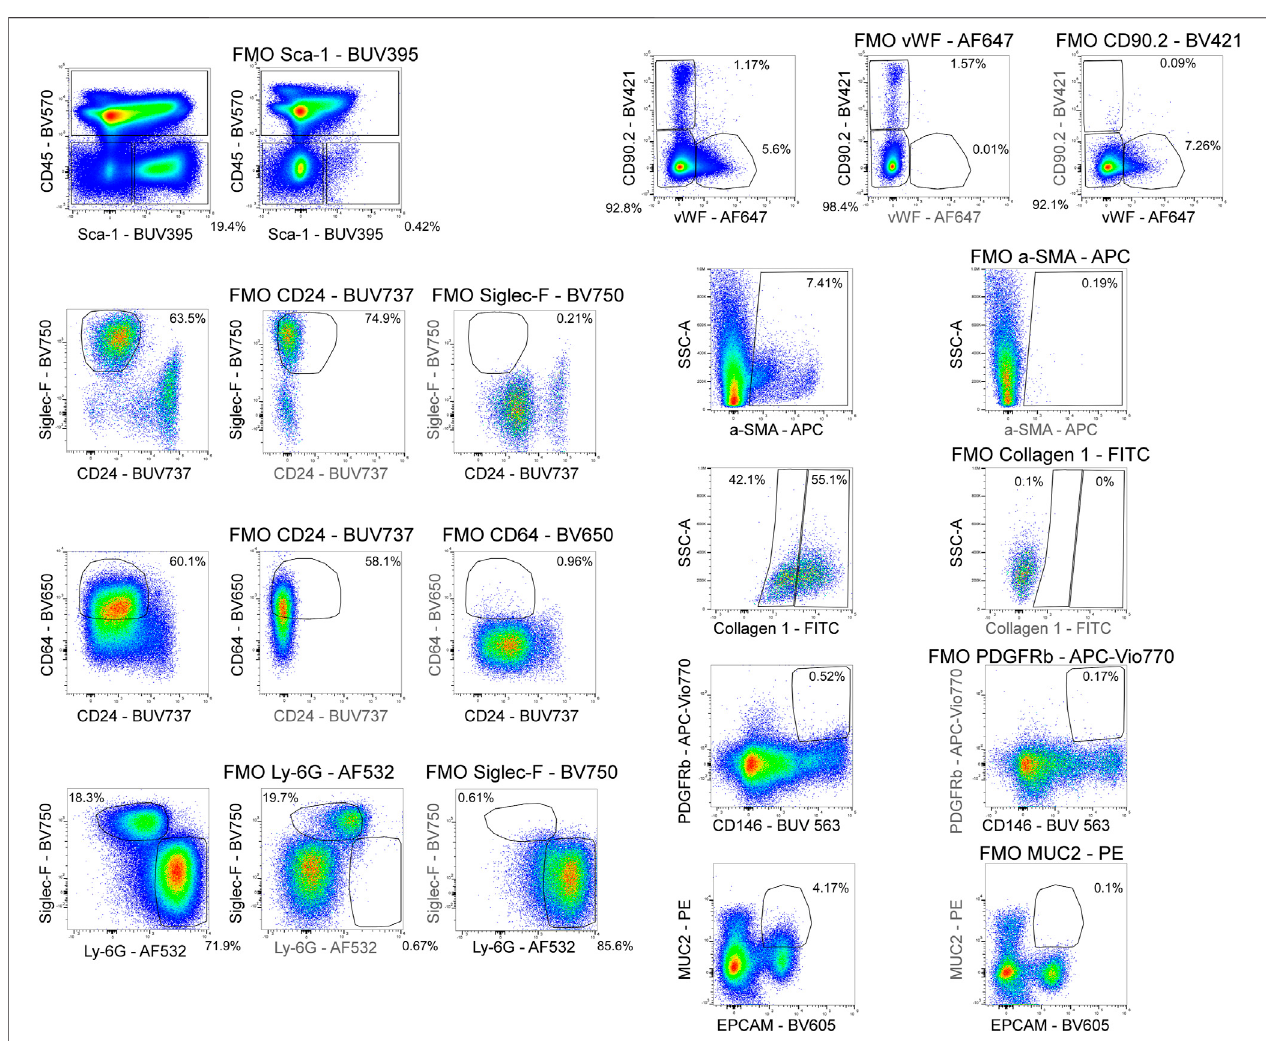
FIGURE 6 | Fluorescence minus one controls. Fluorescence minus one (FMO) controls were used to set gating boundaries in the fully stained sample for parameters where the separation between negative and positive events was not clear or when the expression of a parameter was low.